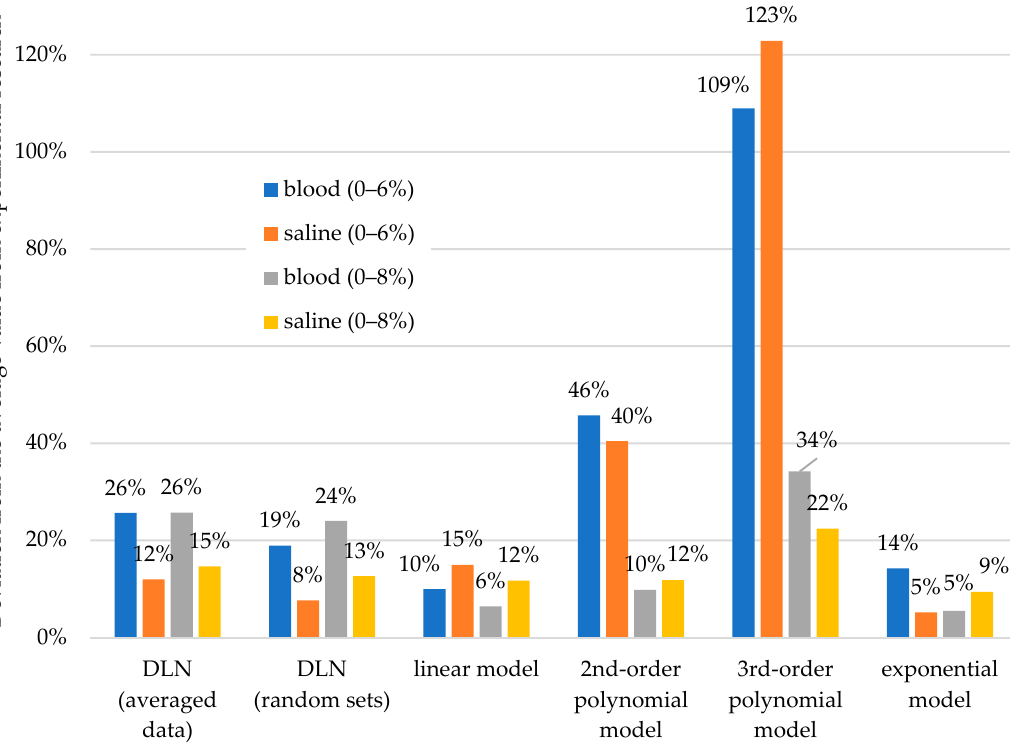
Figure 10. Uncertainty of strength predictions at 10% contamination based on the results obtained by different methods and from different ranges.